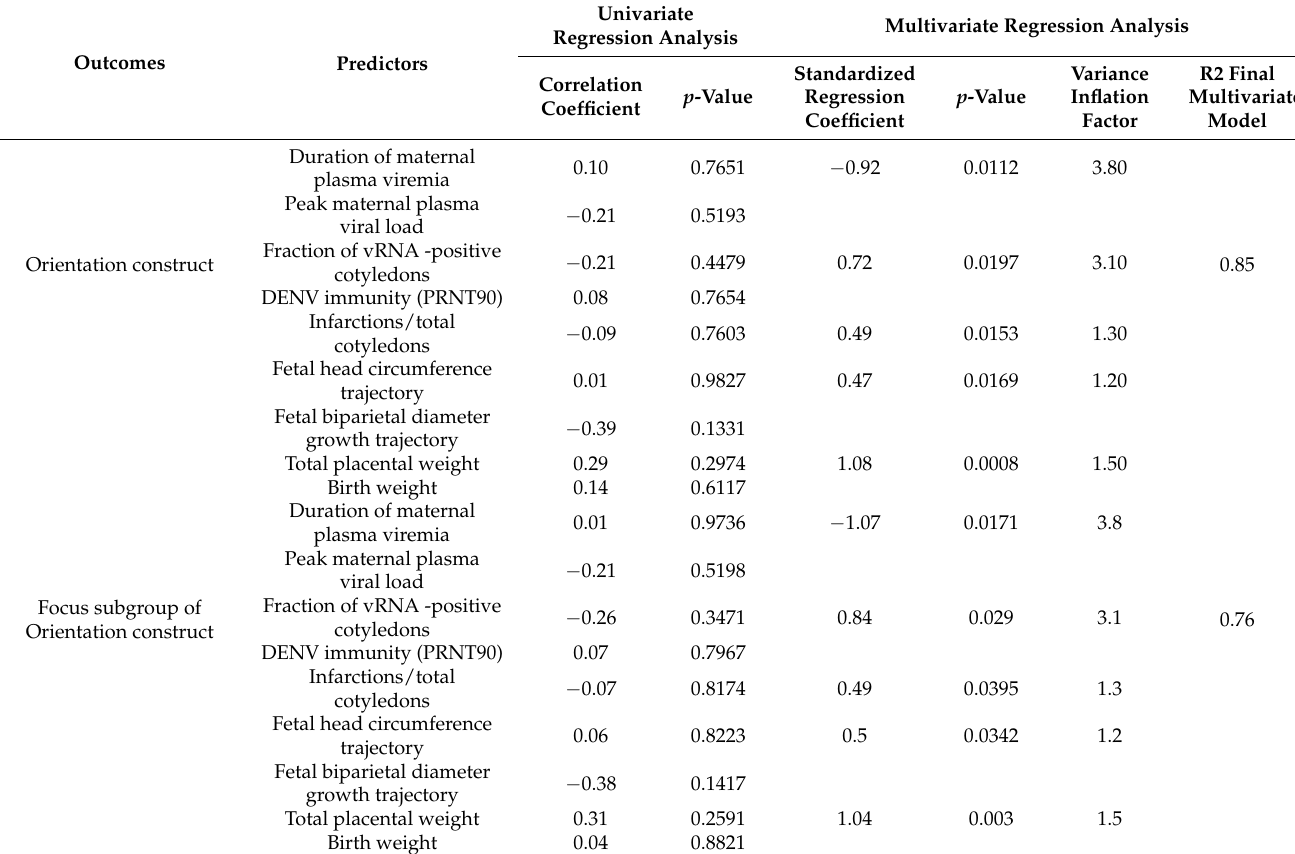
Table 3. Multivariate analysis of maternal ZIKV infection characteristics and pregnancy parameters.